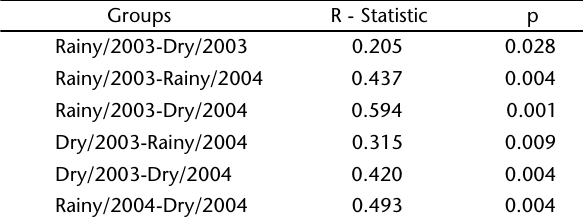
Table III. ANOSIM analyses of similarity between groups of samples in the Caravelas River and the adjacent coastal region. (R) Strength of the difference between groups, (p) probability of R being attained by chance. The global result is the overall differences between groups.